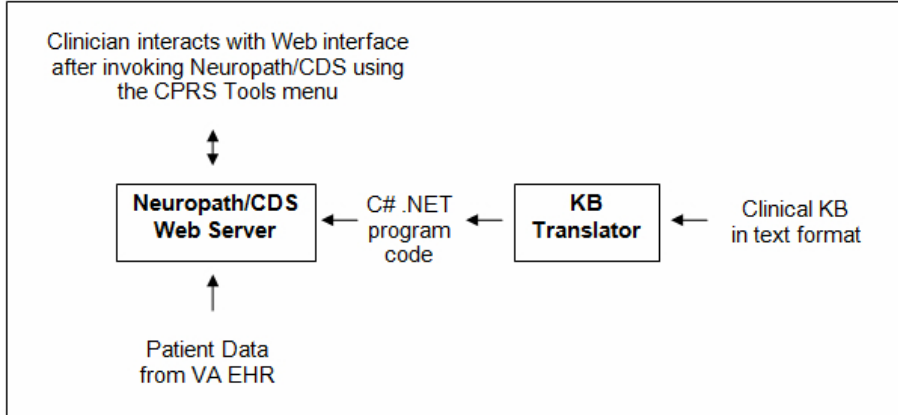
Figure 5. A simplified schematic outline of Neuropath/CDS's technical design. KB=knowledge base; CPRS=computerized patient record system; VA=Veterans Administration; EHR=electronic health